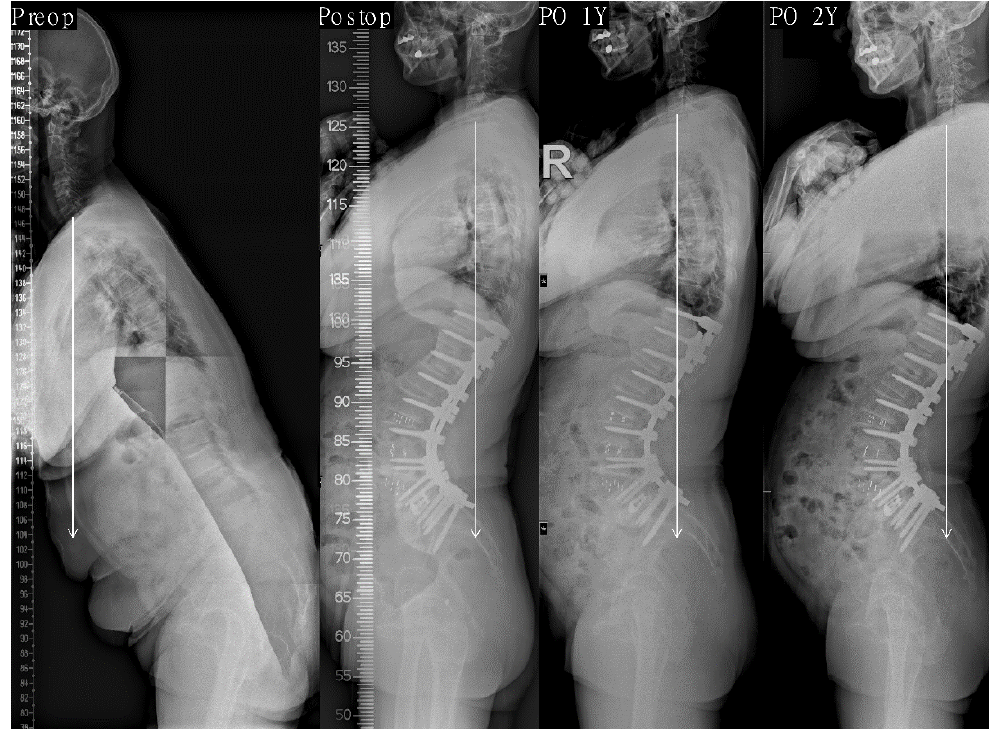
Figure 3. This 67-year-old female presented to us with degenerative sagittal imbalance (SVA + 251 mm, TK 20 ◦ , LL − 20 ◦ , PI 56 ◦ , PT 35 ◦ , SS 21 ◦ ). We performed PCO with LLIF on L2–5 and PLIF on L5–S1. After surgery, lordosis apex was located at L4 and LDI was 71.5%. PI-LL was − 20 ◦ (SVA − 46 mm, TK 39 ◦ , LL − 76 ◦ , PT 1 ◦ , SS 55 ◦ ). Postoperative 1-year whole spine lateral radiograph showing normal sagittal alignment (SVA − 40 mm) and is maintained optimal (SVA − 48 mm) without occurrence of decompensation at the last follow-up period. SVA indicates sagittal vertical axis; TK, thoracic kyphosis; LL, lumbar lordosis; PI, pelvic incidence; PT, pelvic tilt; SS, sacral slope; PCO, posterior column osteotomy; LLIF, lateral lumbar interbody fusion; PLIF, posterior lumbar interbody fusion; LDI, lumbar distribution index.